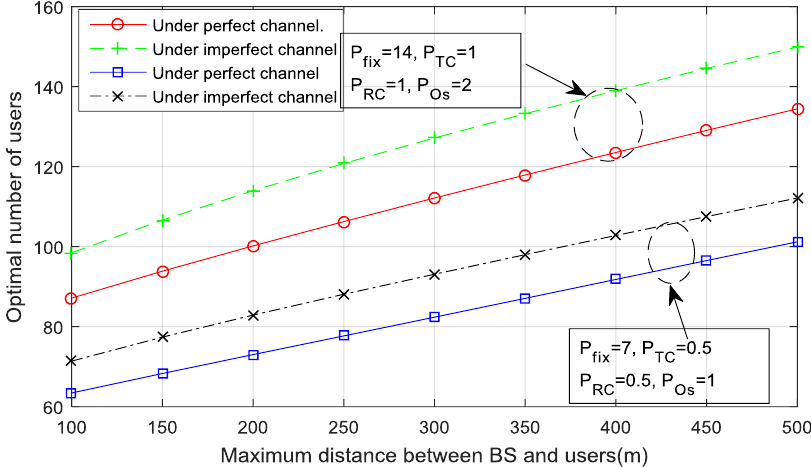
Figure 7. Optimal number of receivers at different area of coverages.